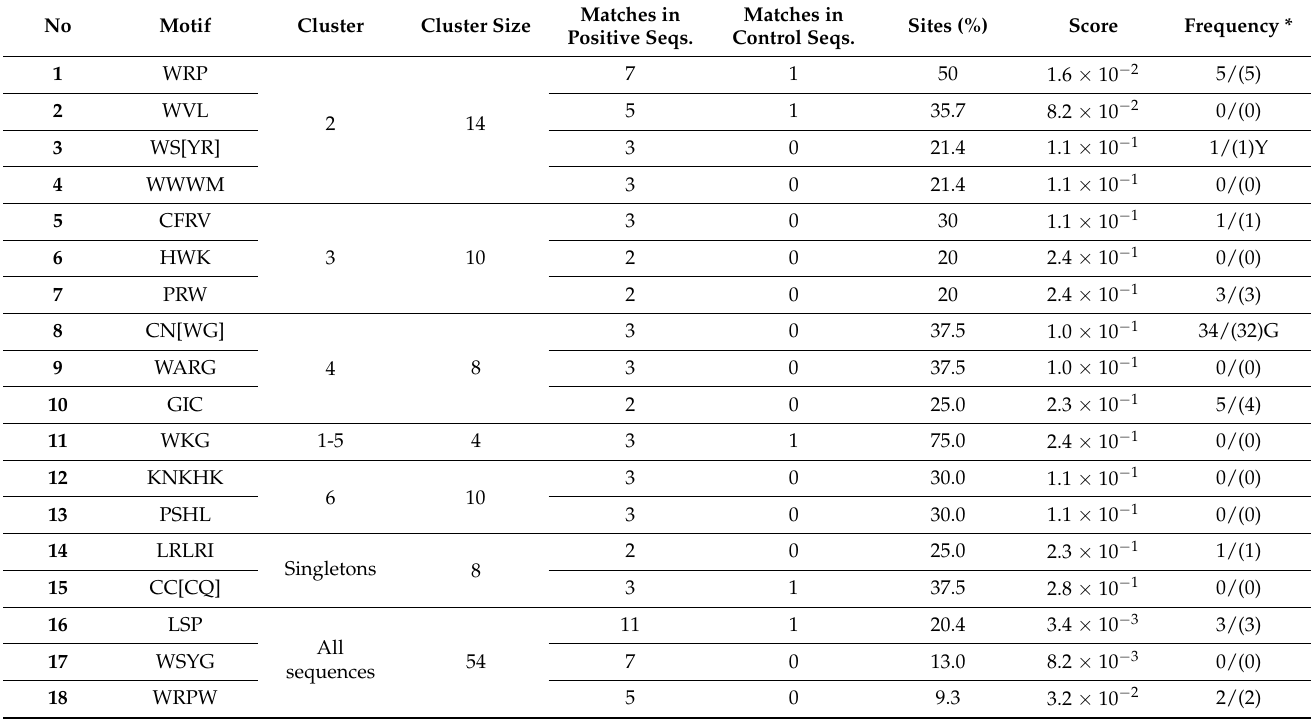
Table 7. Discovered Motifs by STREME.